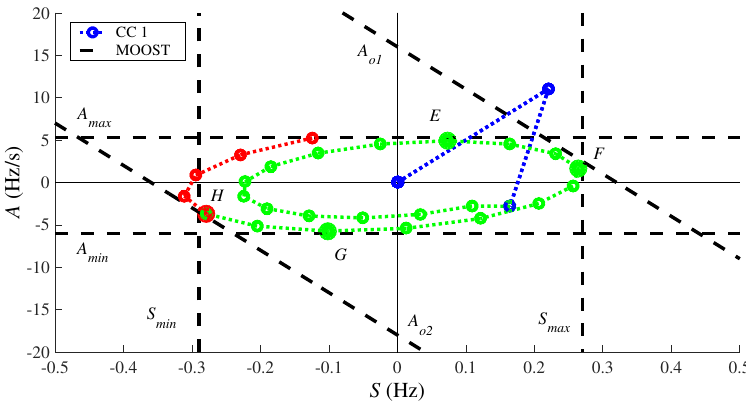
Figure 8. Illustrative tuning of the MOOST